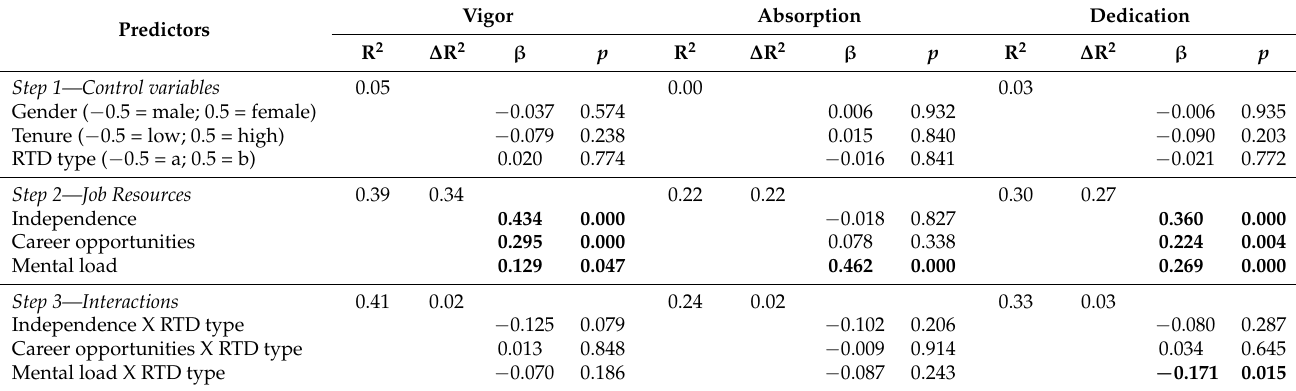
Table 3. Coefficients table of hierarchical regression analysis with Work Engagement dimensions as outcomes ( n = 157).